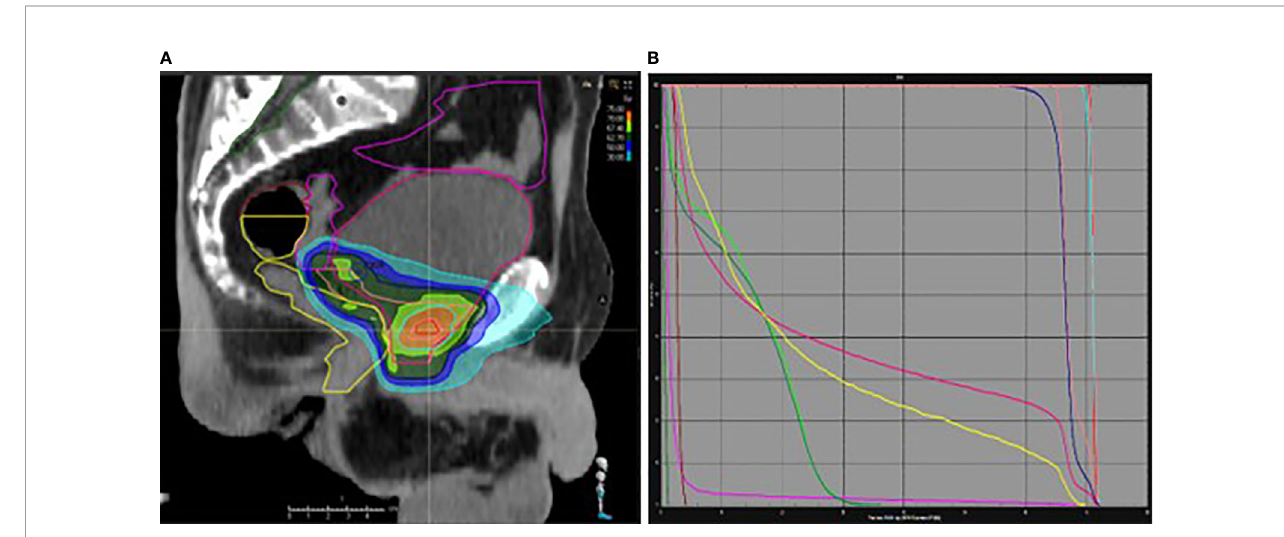
FIGURE 1 | (A, B) Intensity Modulated Radiation Therapy of the prostatectomy bed (66 Gy) with a concomitant boost to the macroscopic recurrence (70.95 Gy). Sagittal view (A) and dose volume histogram (B) . Pink and blue: prostatic bed and macroscopic recurrence CTV and PTV; yellow: rectum; red: bladder; green: femoral